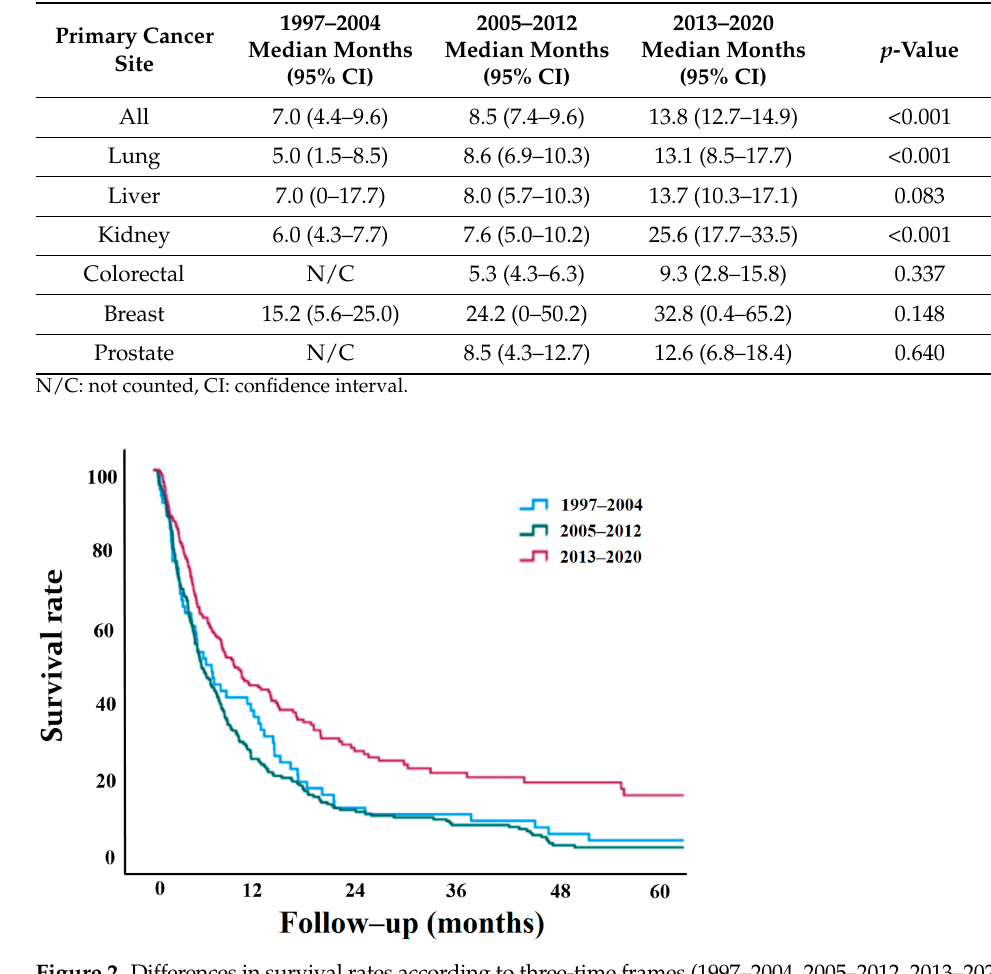
Figure 2. Differences in survival rates according to three-time frames (1997–2004, 2005–2012, Table 4. Trends of survival in the top six common primary cancer sites according to the three time frames.